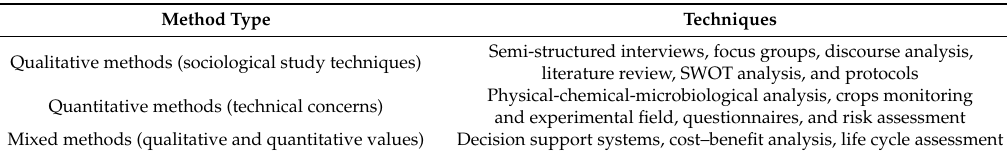
Figure 2. Geographic analysis of selected publications by typology, and year of publication. Note: Template courtesy of www.yourfreetemplates.com. Table 4. Methods and techniques used for the analysis.